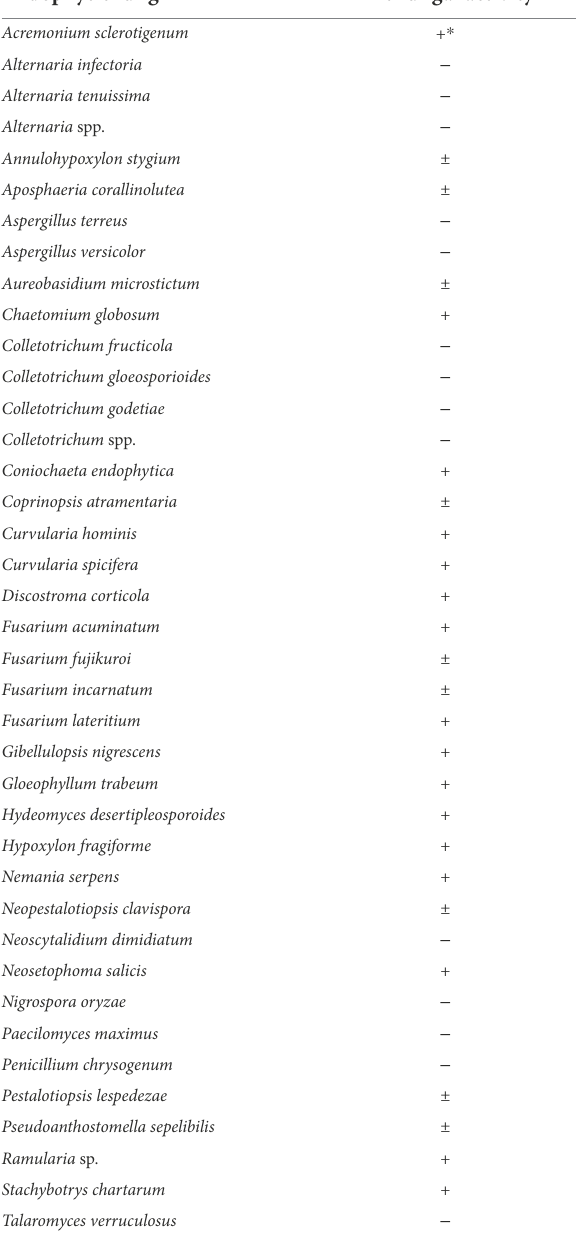
TABLE 2 Antifungal activity of endophytic fungi isolated from apple based on the cellophane membrane-based